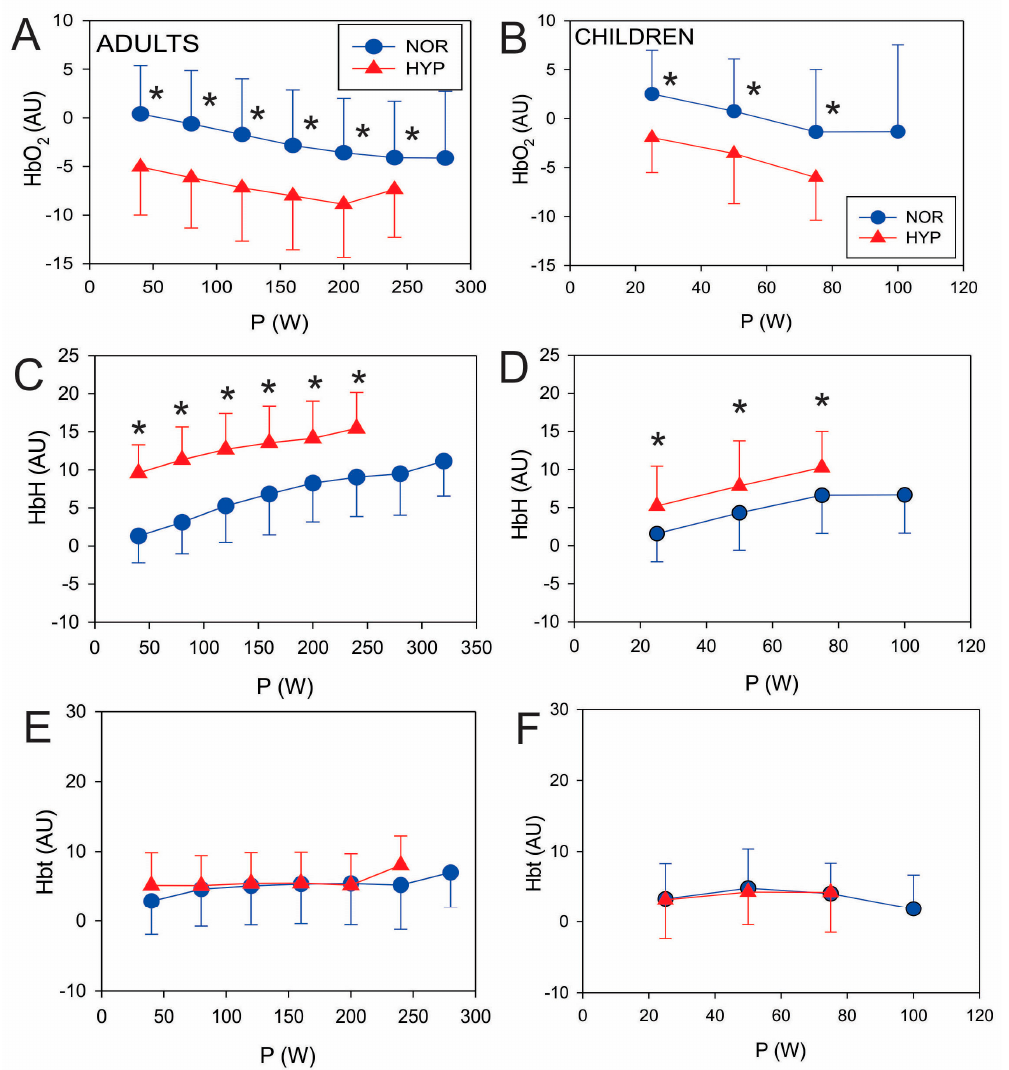
Figure 3. Exercising values of oxygenated haemoglobin (O 2 Hb; panels ( A , B )), deoxygenated haemoglobin (HHb; panels ( C , D )) and total haemoglobin (tHb; panels ( E , F )) for both adults and children. Values are reported as means (SD). Significant post hoc differences: * ( p < 0.05) denotes significantly different values compared to